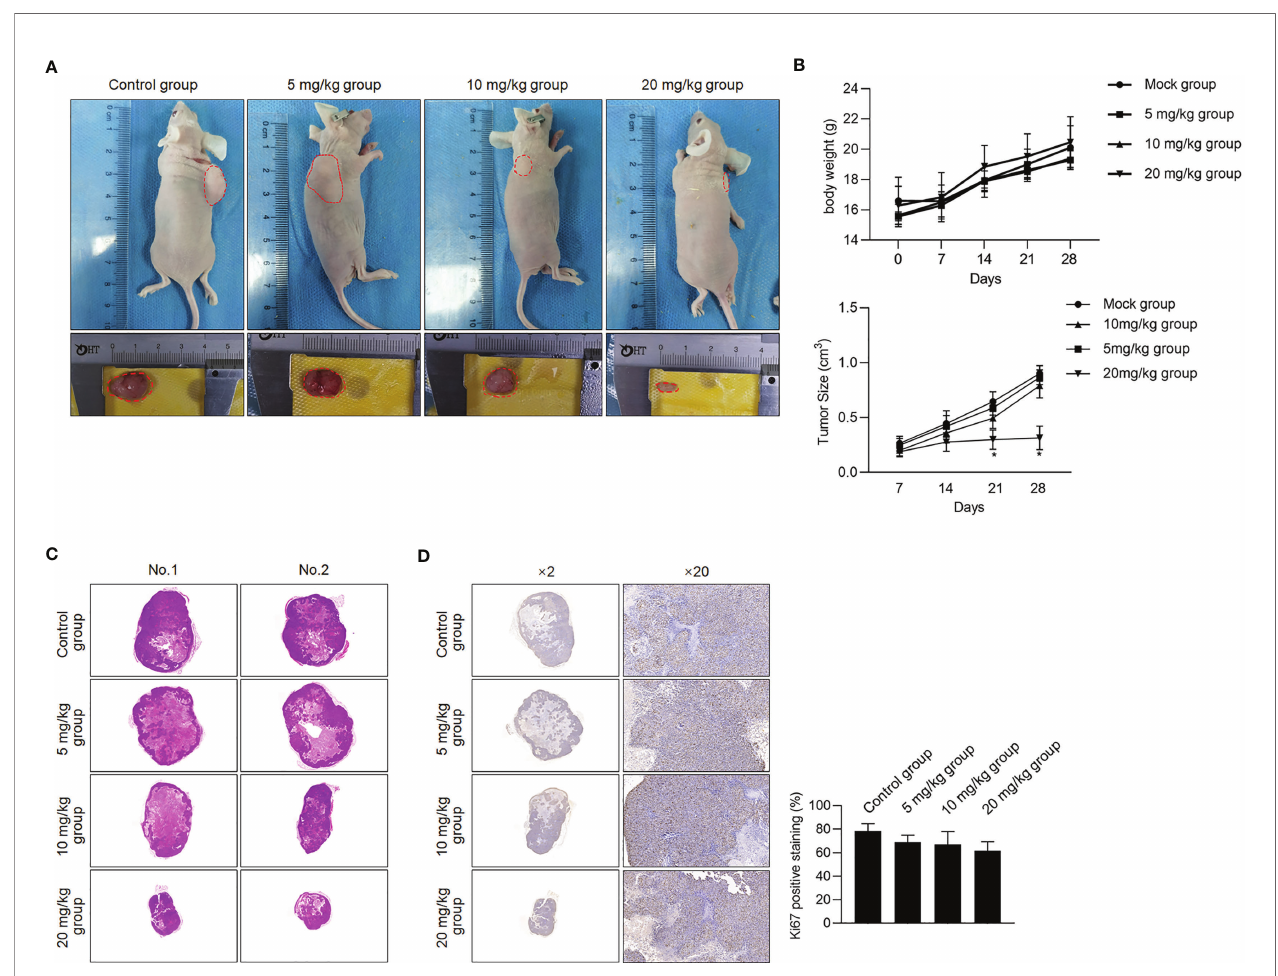
FIGURE 6 | Berberine inhibited in vivo tumor formation ability. (A) Volume of CSCs formed tumors in nude mice after seeding 5 × 10 5 cells. (B) Weight of nude mice and size of seeded tumors were measured at 7, 14, 21, and 28 days after transplantation. *p < 0.05, vs. mock group. Tumor formation was morphologically identi fi ed by H&E staining (C) , and cell proliferation marker Ki-67 (D) were further